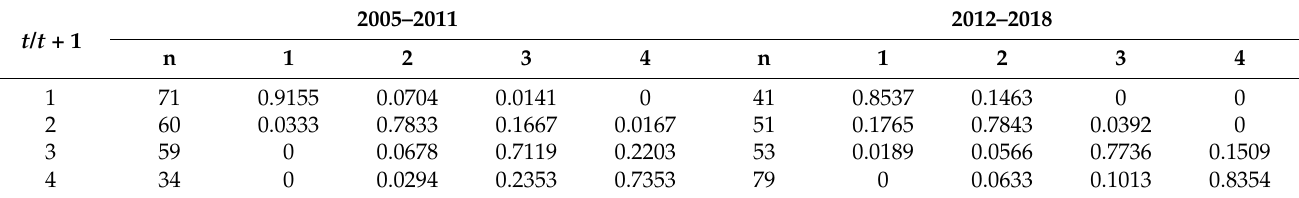
Table 5. Traditional Markov probability transfer matrix of the RNCUE